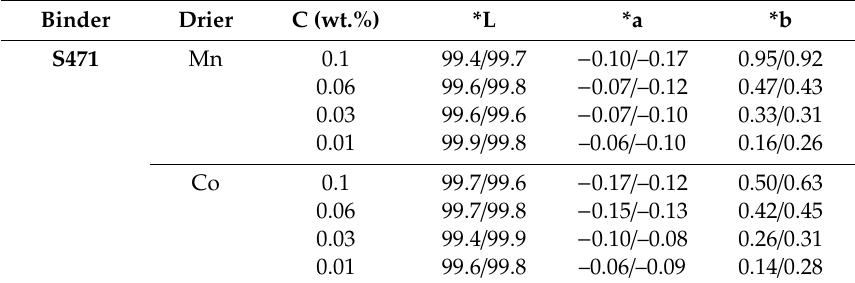
Table 3. Coloration of coatings of S471 treated with Mn and Co. 1